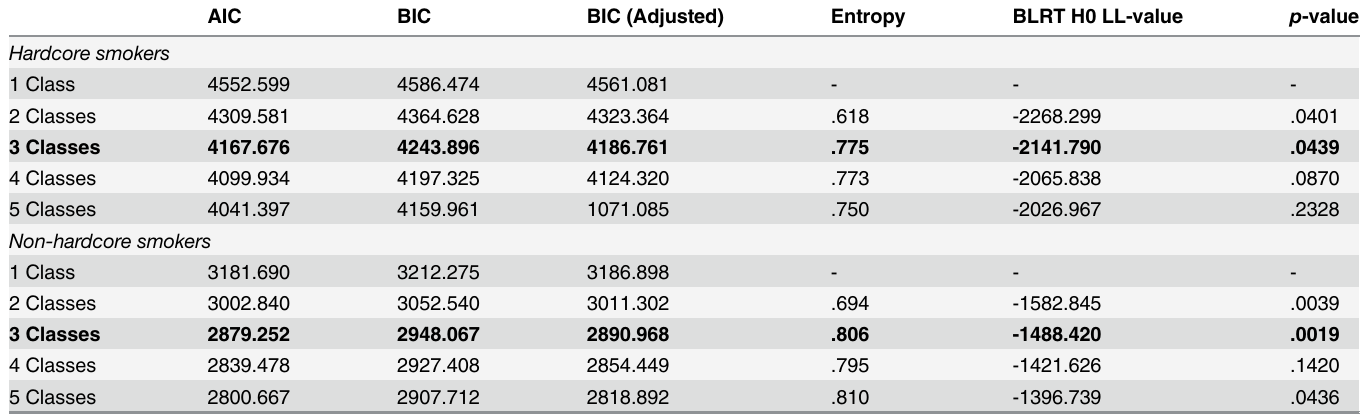
Table 2. Latent profile analysis models in hardcore smokers and non-hardcore